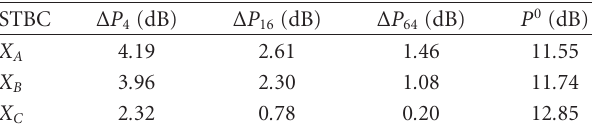
Table 1: PAPR Reduction results for Di ff erent Space-Time Block Codes and Modulation Types.